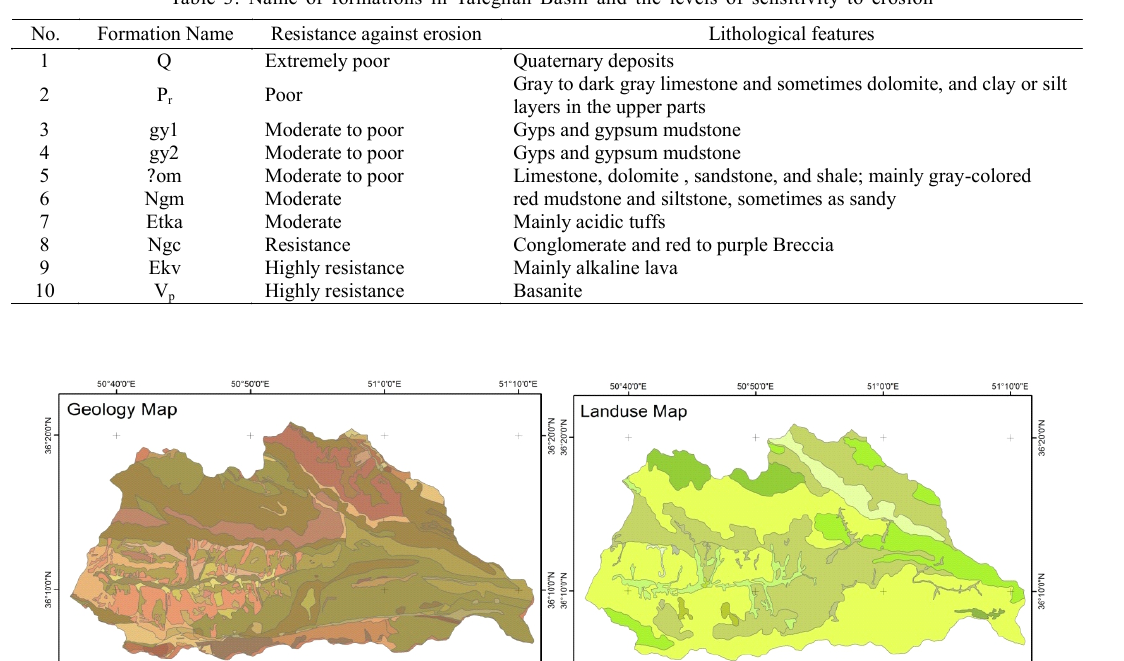
Table 3: Name of formations in Taleghan Basin and the levels of sensitivity to erosion